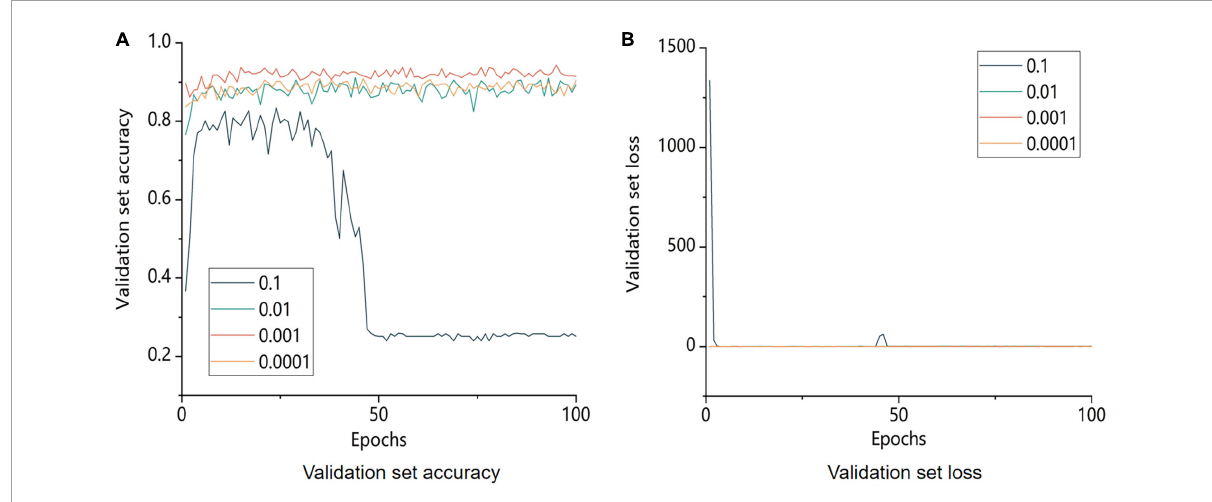
FIGURE10 Comparison of accuracy and model loss of the validation set with different learning rates. 0.1, 0.01, 0.001, and 0.0001 are the learning rate parameters set by the model, respectively. A is the image of the change in accuracy of the validation set and B is the image of the change in loss value of the